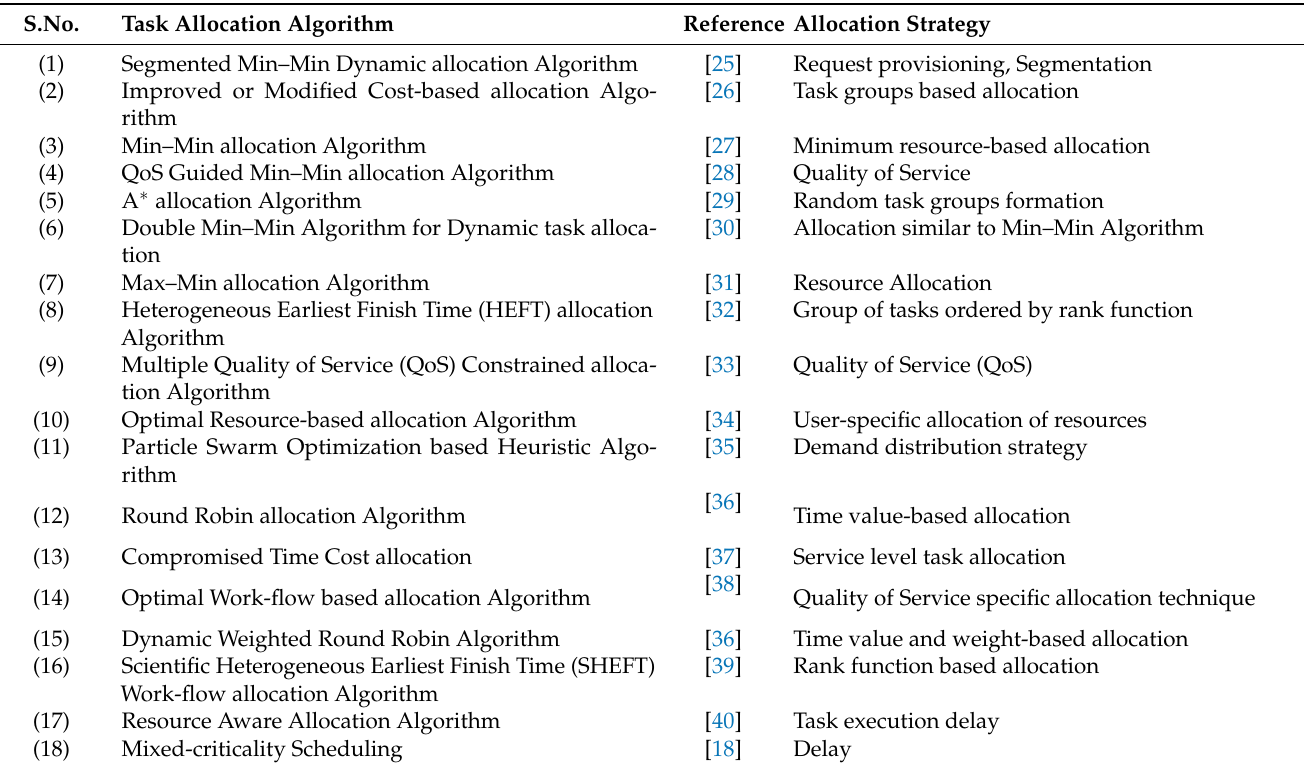
Table 2. Survey of Task allocation Algorithms For Distributed Computing